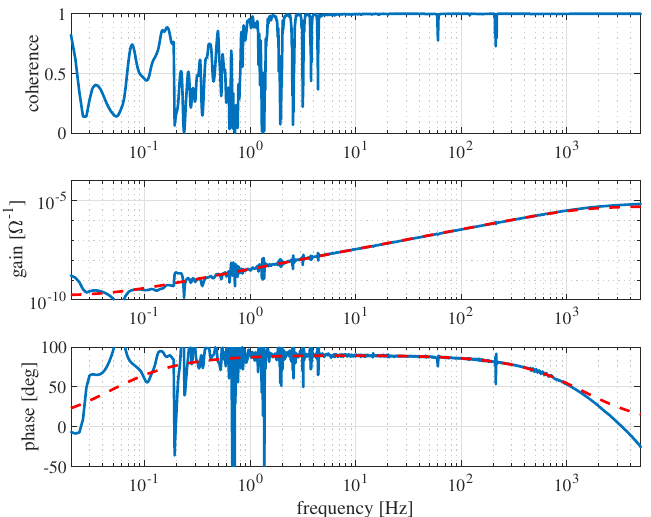
(red dashed line) is elec